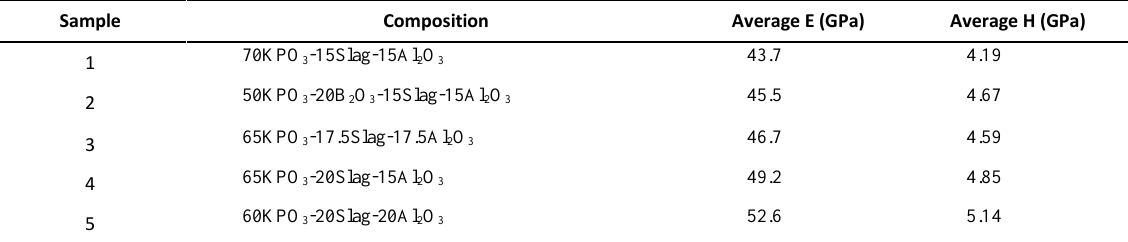
Table 5: Average elastic modulus and hardness of the samples of Series 2 consisting of slag.